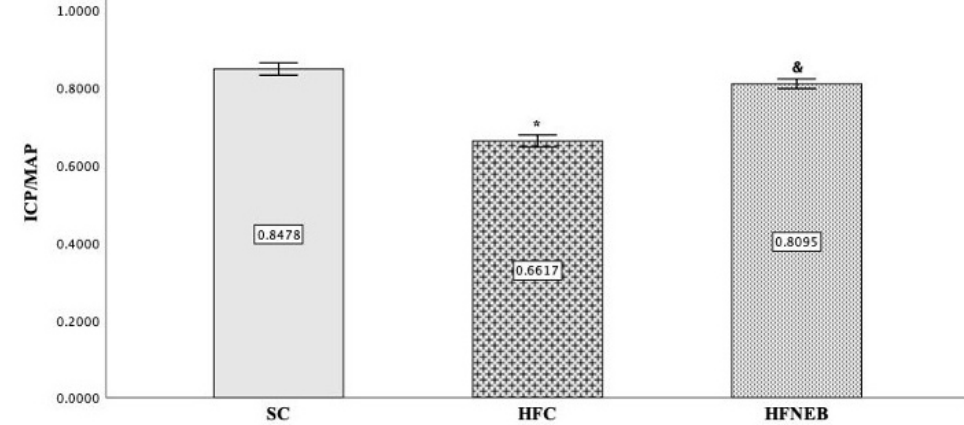
Fig. 3. Erectile functions characterized by ICP/MAP . Compared to SC group, HFC rats were characterized by decreased ICP/MAP ratio. Nebivolol treatment prevent this decrease ( p < 0.05 *compared to SC, & compared to HFC).